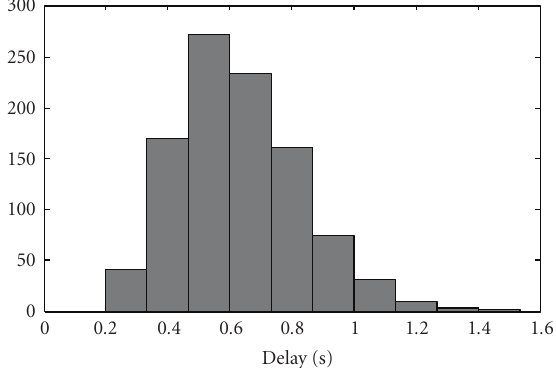
Figure 13: Histogram of minimum bu ff ering delay for one service in DetMux.